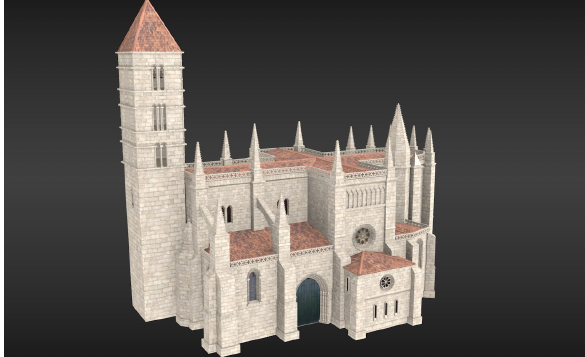
Figure 2: The virtual reconstruction of the current state of “La Antigua” rendered with